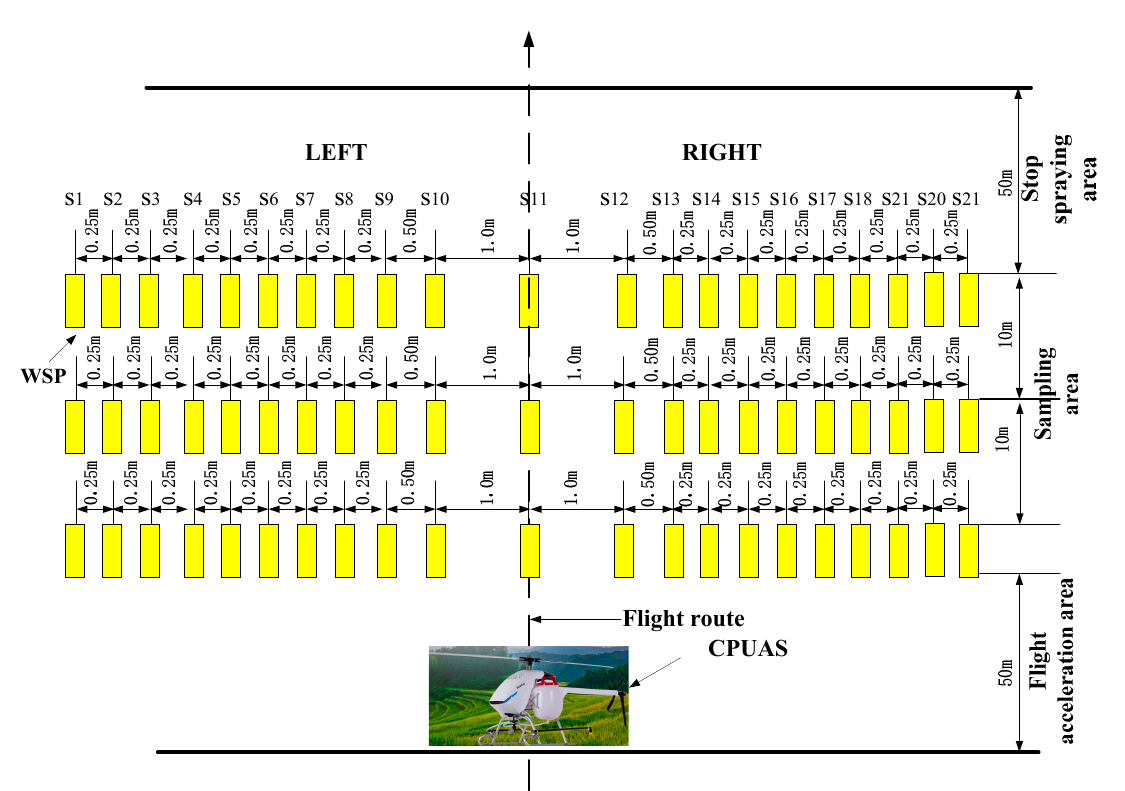
Figure 2. The field sampling layout (top view).